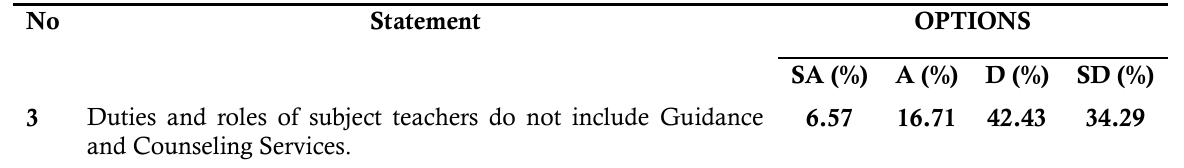
Source: questionnaire number